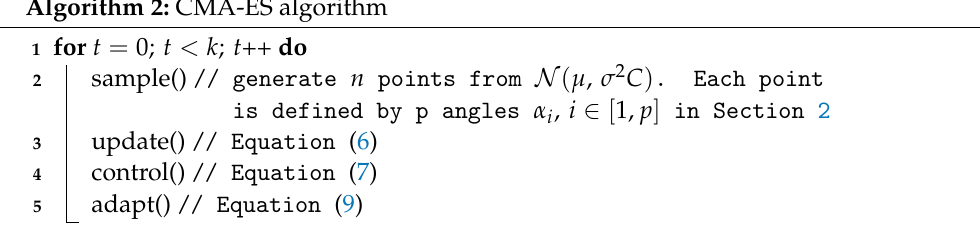
Algorithm 2: CMA-ES